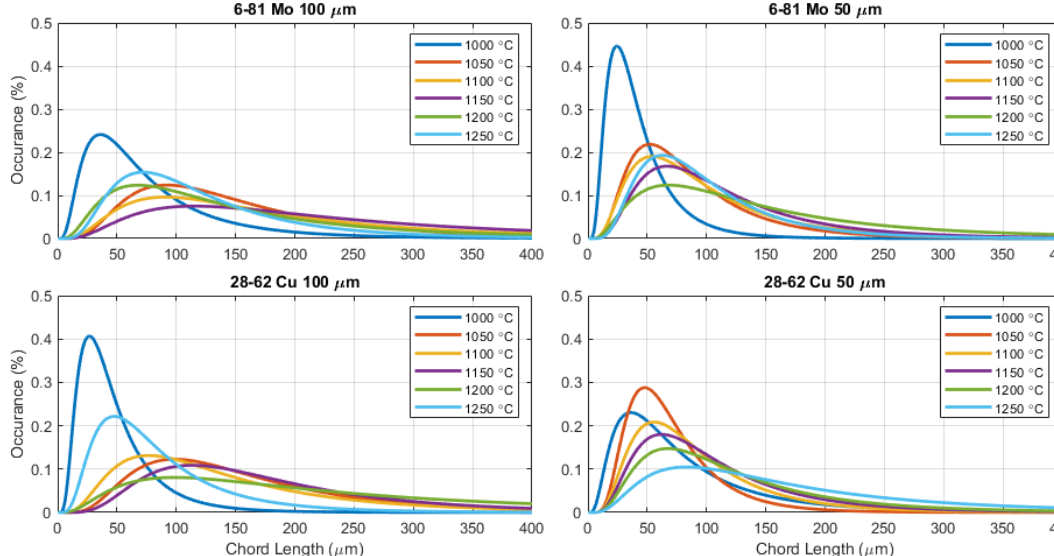
Figure 12. Chord-size histograms for each material and thickness showing the effect of heat-treatment temperature on grain size.